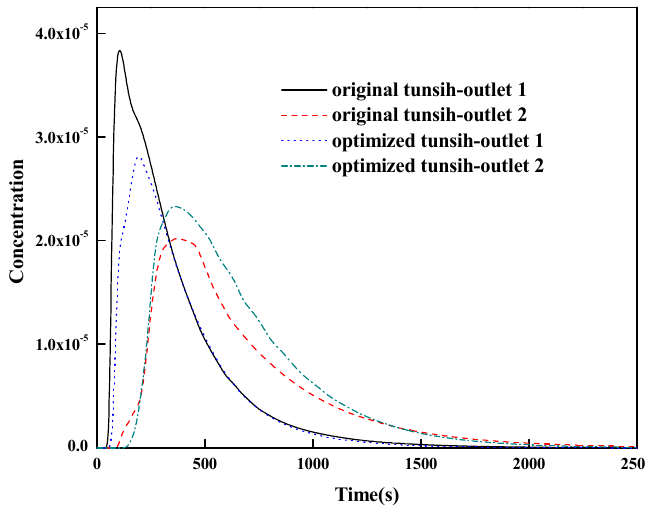
Figure 6. Fluid flow in the optimized tundish.